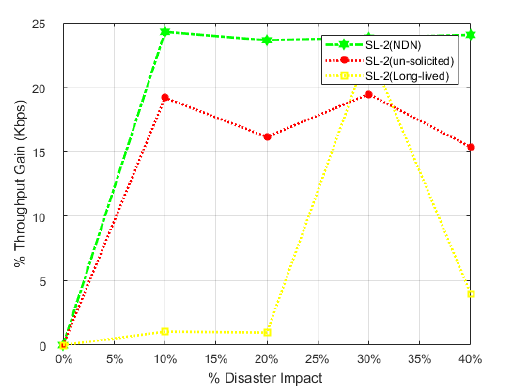
Figure 12. Throughput Gain w.r.t NDN-DISCA to Existing Schemes i.e., NDN, Un-solicited and Long-lived in